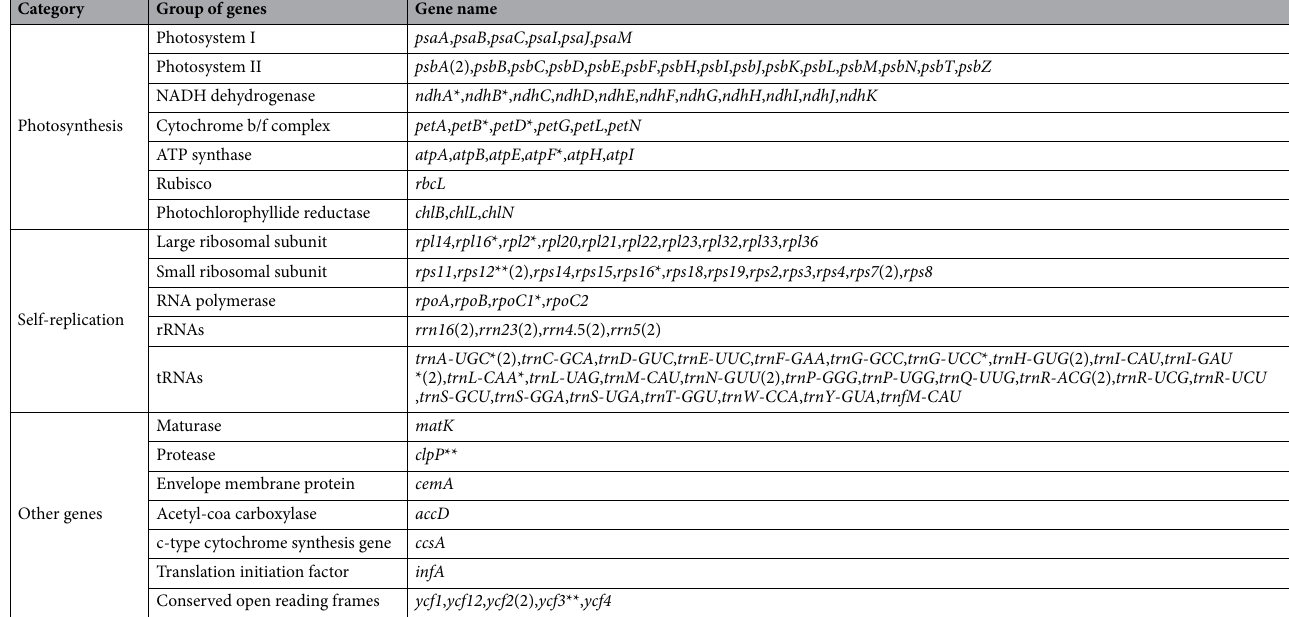
Table 2. Gene classification of S. lepifera . Gene*: Gene with one intron; Gene**: Gene with two introns; and Gene (2): Number of copies of multi-copy